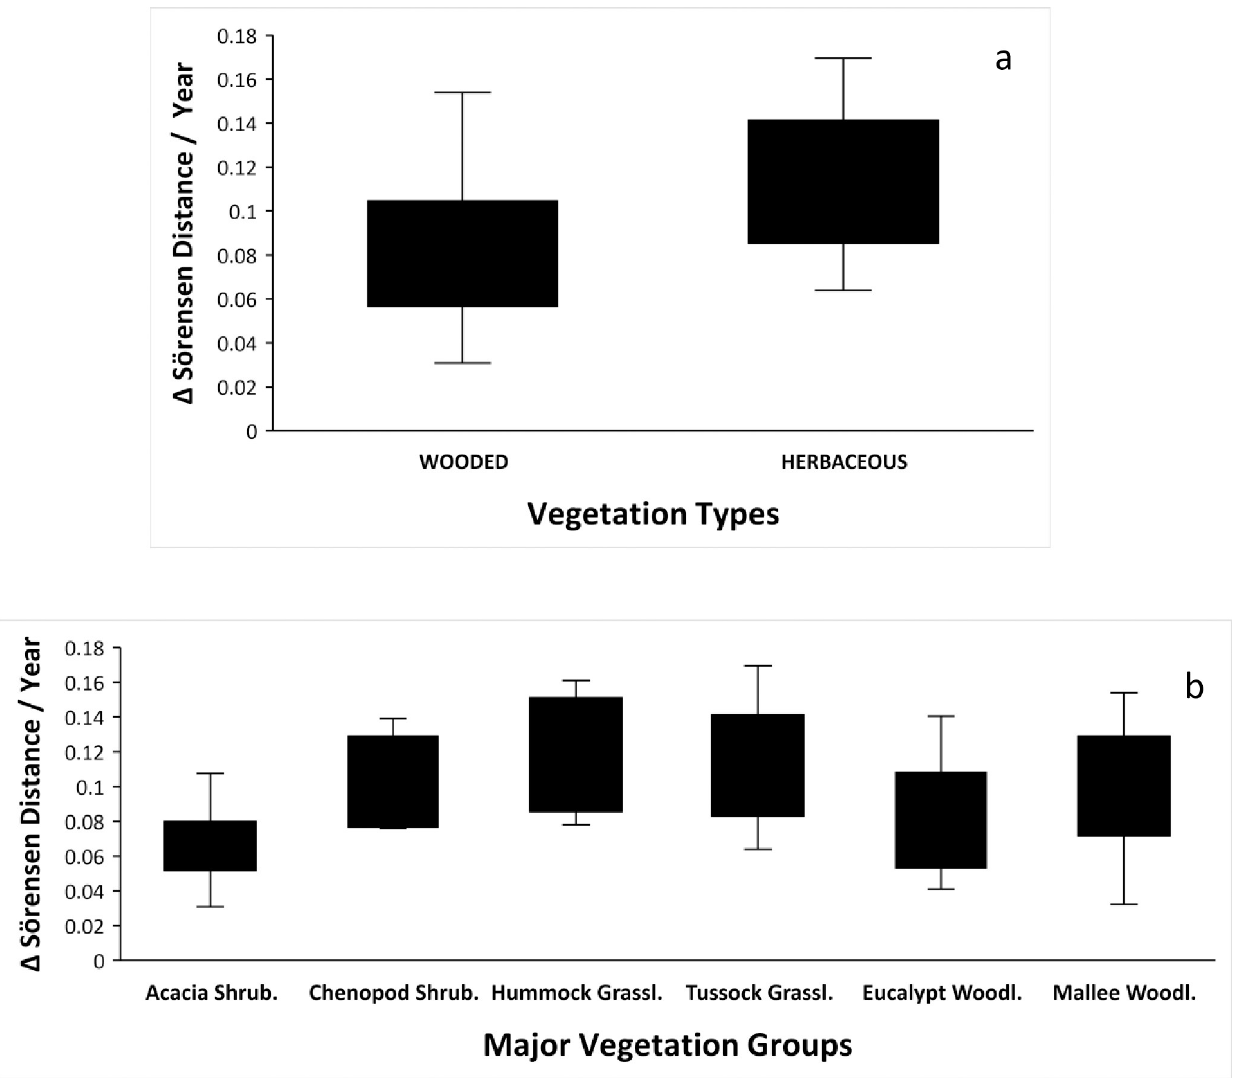
Fig 4. Annualized floristic So¨rensen distances. Annualized floristic So¨rensen distances for revisits after more than 4 years. (a) Contrast between Wooded and Herbaceous vegetation types. ANOVA F (1,56) = 11.27; P = 0.001. (b) Contrast between six Major Vegetation Groups. Global ANOVA F (5,53) = 2.90; P = 0.022. Only Acacia Shrublands and Tussock Grasslands are statistically different at P = 0.025.